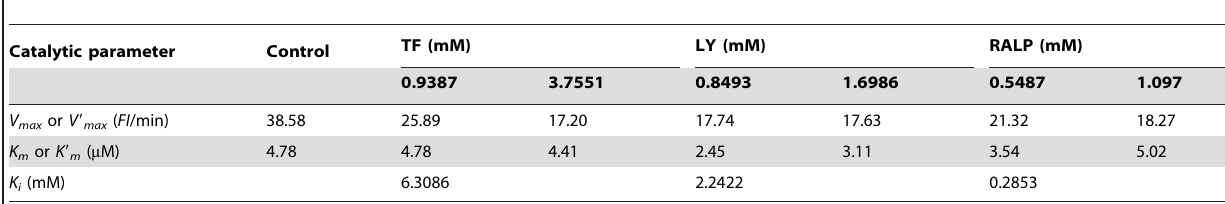
Table 2. Kinetics constants of renin-catalyzed reaction at different peptide concentrations.